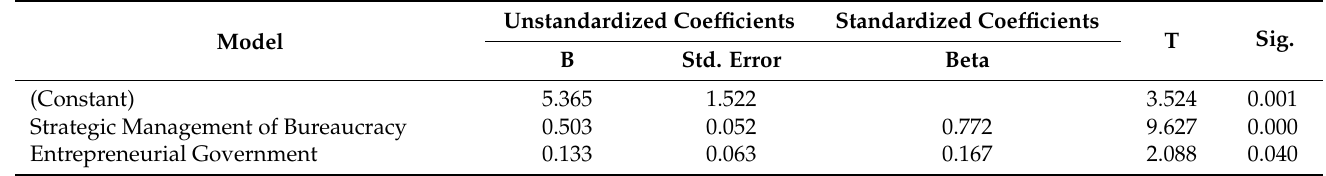
Table 2. ANOVA or F-test Results Statistics.